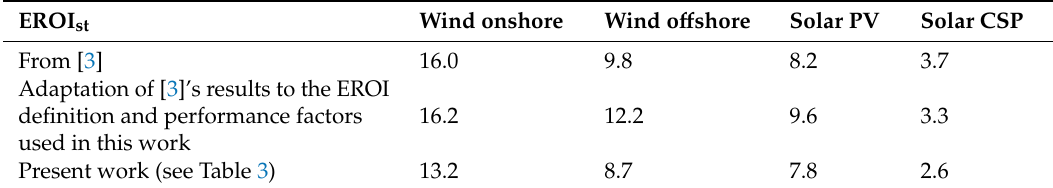
Table A3. Comparison of the EROIst levels estimated in the present work and from Capell á n-P é rez et al. [3]. The first line reports the original results while the second is adapted to the EROI definition and performance factors used in this work and is then comparable with the third